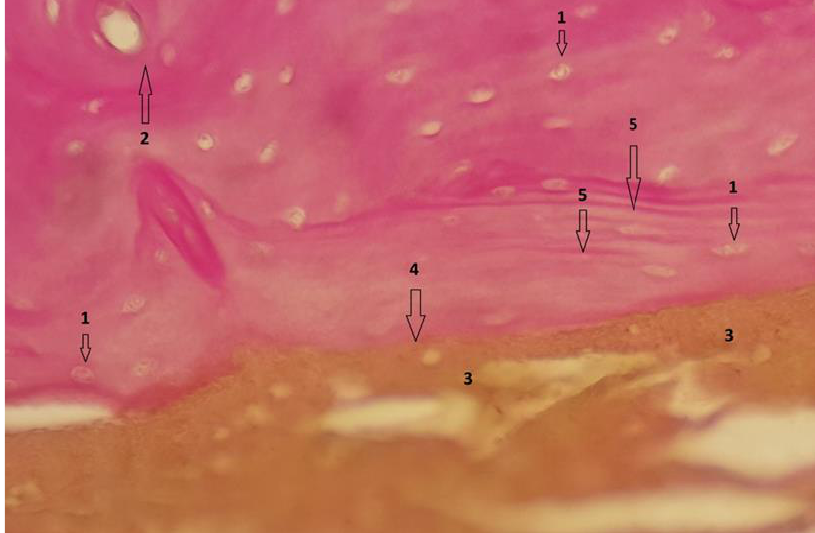
Figure 22. Bone tissue, showing viable bone cells with intracytoplasmic nucleus, visible in section,